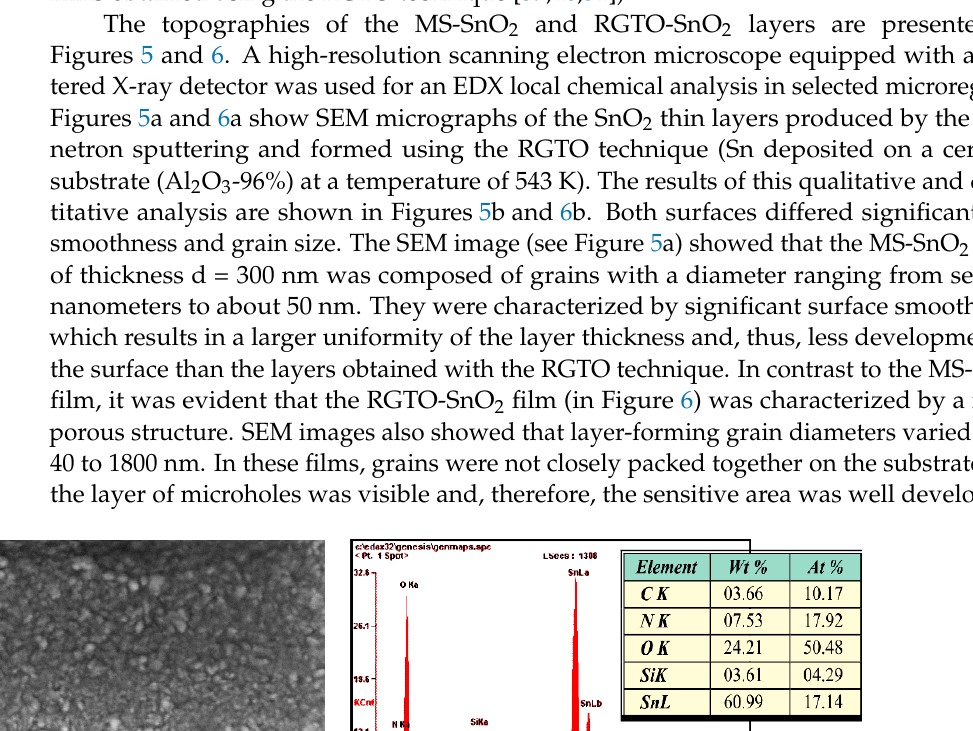
( b ) Figure 6. ( a ) SEM image of the RGTO-SnO 2 film surface (6000×) (Sn deposited on alumina substrate at 270 ℃ ) and ( b ) results of (SnO 2 ) microanalysis (qualitative and quantitative analysis). SEM and AFM analyses acknowledge the existence of conductive “bridges” during tin oxidation in the RGTO process that contributed to the SnO 2 film sensitivity, reported previously by other authors [52]. Such facts are significant because the thickness and po- rosity of layers strongly influence toxic and explosive gas sensing abilities. 3.3. Auger Electron Spectroscopy (AES) To better understand the chemical composition of the MS-SnO 2 and RGTO-SnO 2 lay- ers, surface analytical measurements and Auger electron spectroscopy combined with Ar + sputtering were used. Auger spectra, registered in layer etching time, are described in Figure 7. Elements were identified using the handbook of standard Auger spectra and Avantage Peak Database Editor (Thermo VG Scientific) [53]. Figure 7a shows examples of survey spectra for the MS-SnO 2 sample. The Sn (MNN) stable intensity (424.5 eV) and O (KLL) (511 eV) signals were clearly visible during sput- tering, reflecting analytical results at various depths of the sample within the tin oxide layer. After sputtering the SnO 2 layer away, the substrate spectra revealed the presence of silicon Si (LVV) (78 eV) and oxygen O (KLL) (507 eV). The layer thickness was about 300 nm. For the RGTO-SnO 2 film, the major oxygen peak was located at the energy of 506.5 eV, and there was a minor peak at 484 eV (Figure 7b). The series of peaks from 315.0 to 464.0 eV were characteristic of tin, which had its highest peaks at approximately 420.5 eV. The carbon peak was located at 263 eV. To calculate the atomic concentration of elements in the MS-SnO 2 film, the Auger peak area (after background removal) was used. Sensitiv- ity factors for carbon, tin, and oxygen were 0.555, 0.214, and 0.15, respectively. For the MS-